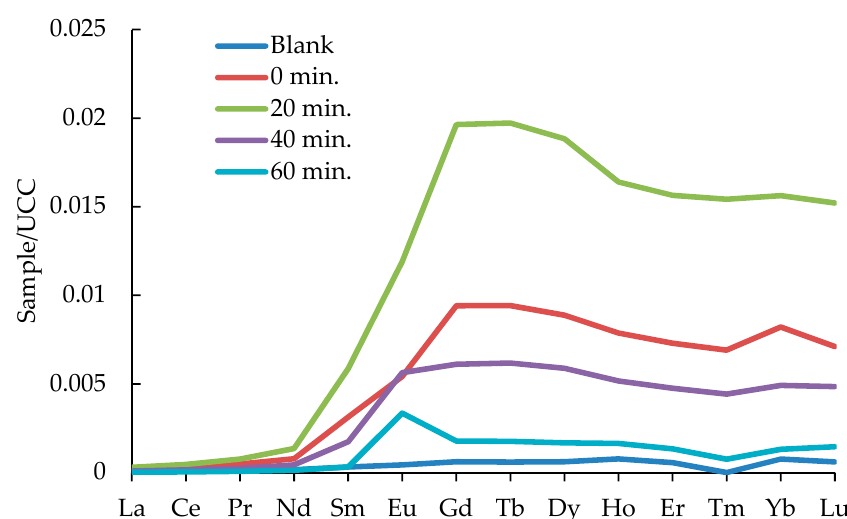
Figure 6. REE concentration (in µg/L) in effluent PLS collected during flow-through leaching of Middle Kittanning underclay (UC-02) powder. Black dots denote sampling points taken during continuous flow. Green dots indicate samples taken after various shut-in times.